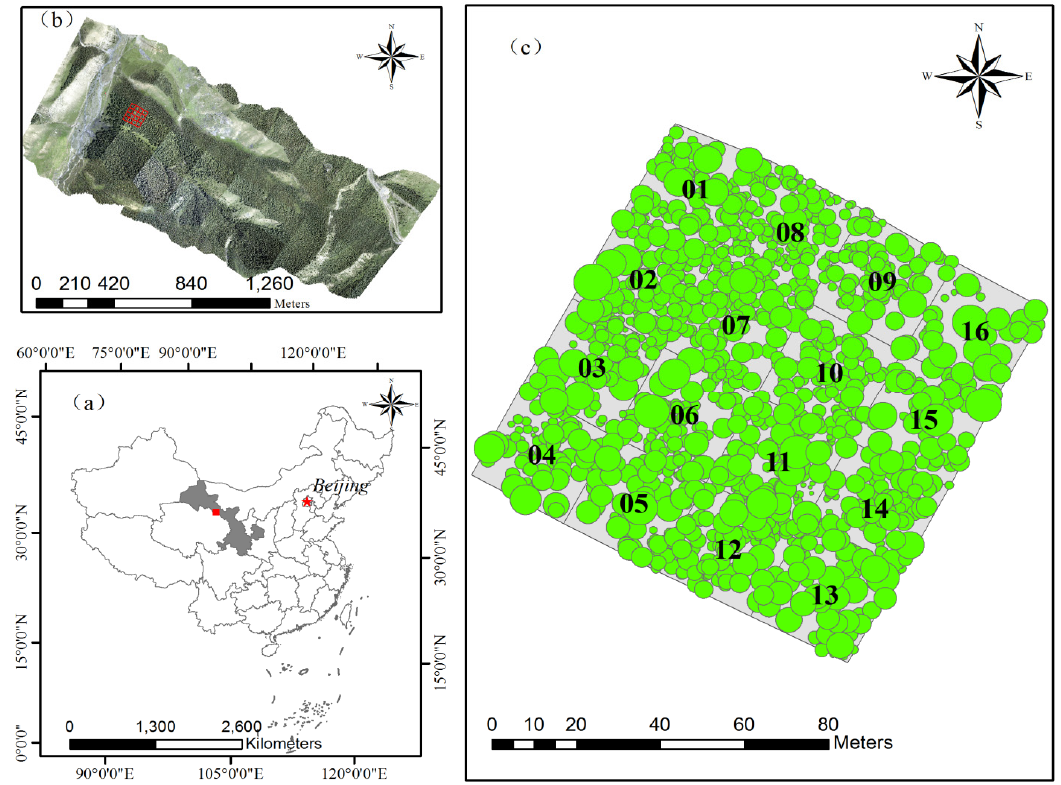
Figure 1. ( a ) Location of the study site: Xishui forest farm located in Su’nan Yuguzu Autonomous County of the Gansu Qilian Mountains National Nature Reserve, Western China; ( b ) spatial distribution of flight lines on orthorectified charge-coupled device images (WGS1984 UTM Zone 47N); and ( c ) tree positions within 16 sub-sample plots within a permanent sample plot of 100 m × 100 m.